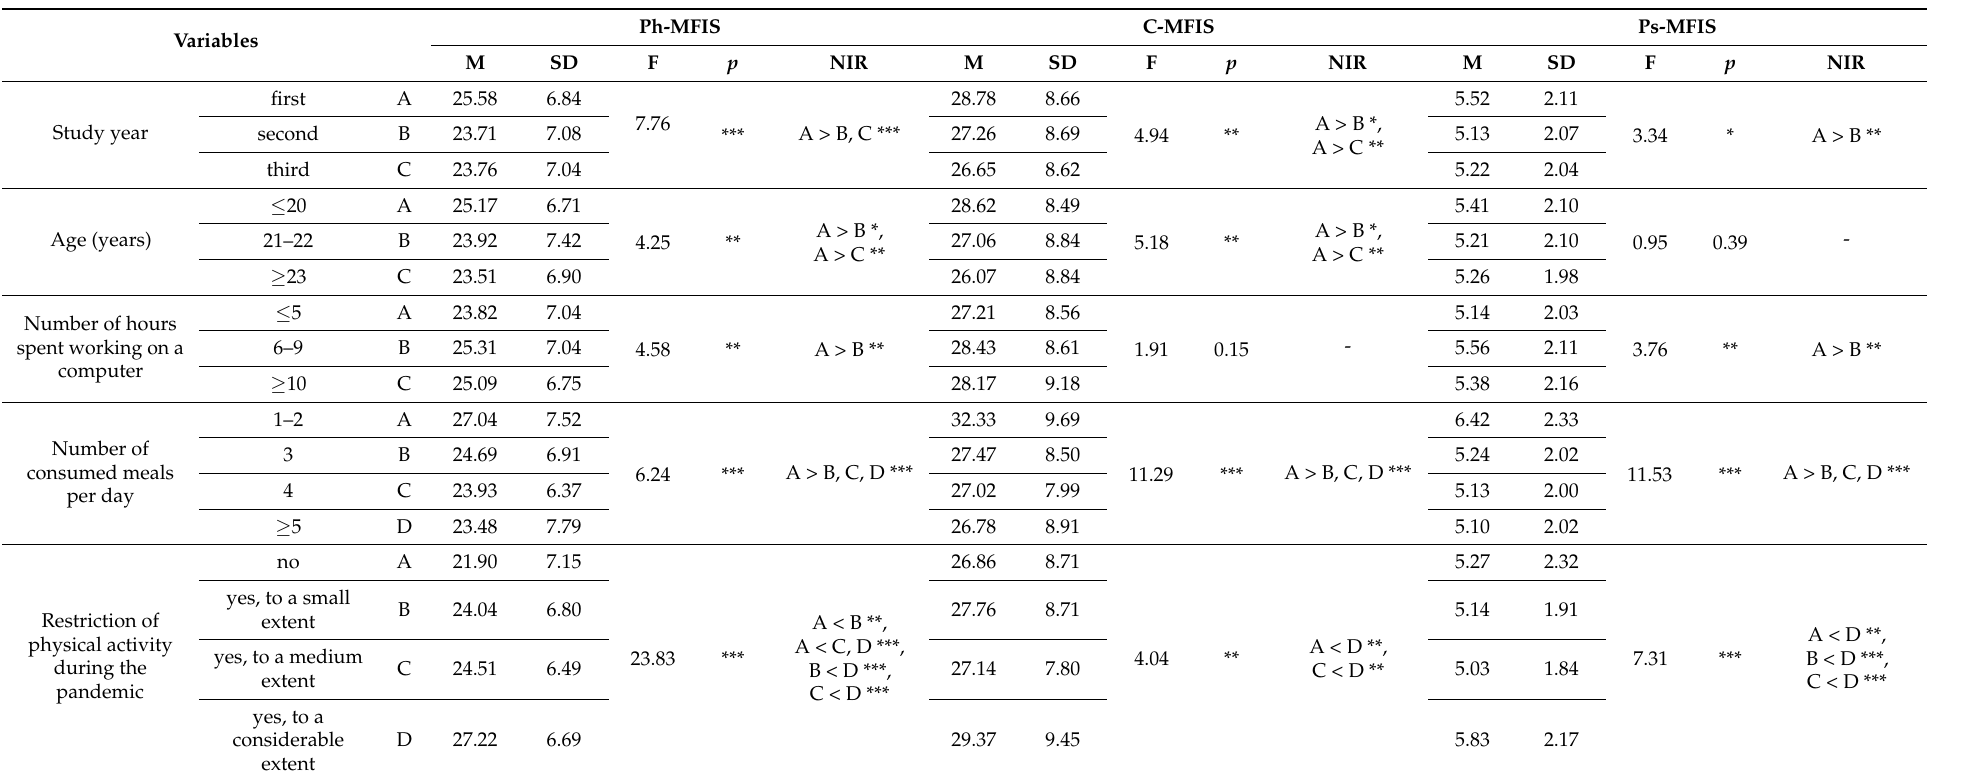
Table 3. The results of the test for significance of the effect of socio-demographic and lifestyle variables on fatigue in general, physical, cognitive, and psychosocial